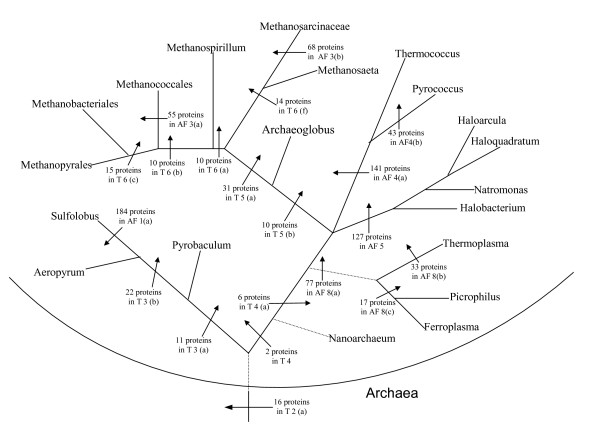
A summary diagram showing the branching order of different groups within archaea based upon species distribution patterns of various archaeal-specific proteins. The arrows mark the suggested evolutionary stages where proteins that are uniquely shared by the indicated groups were introduced. The details of these proteins can be found in the indicated tables (T) or Additional files (AF). The branching pattern shown here is unrooted. The dotted line for N. equitans indicates that its placement within Euryarchaeota is uncertain. The dotted line extending from the proteins found in all archaea indicates that one cannot use this to root the archaeal tree.